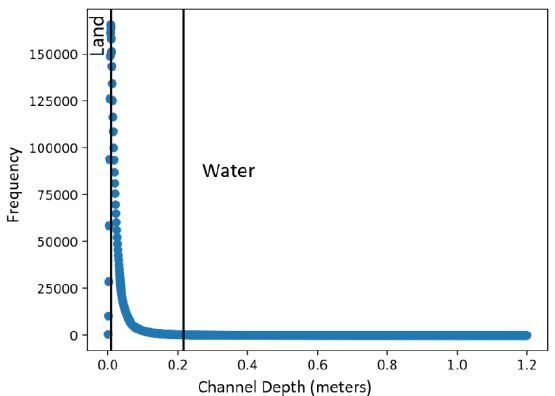
Figure 5. Histogram of 2-D shallow water channel depth values for a watershed with mode threshold of likely land (non-water) and second derivative threshold for likely water.